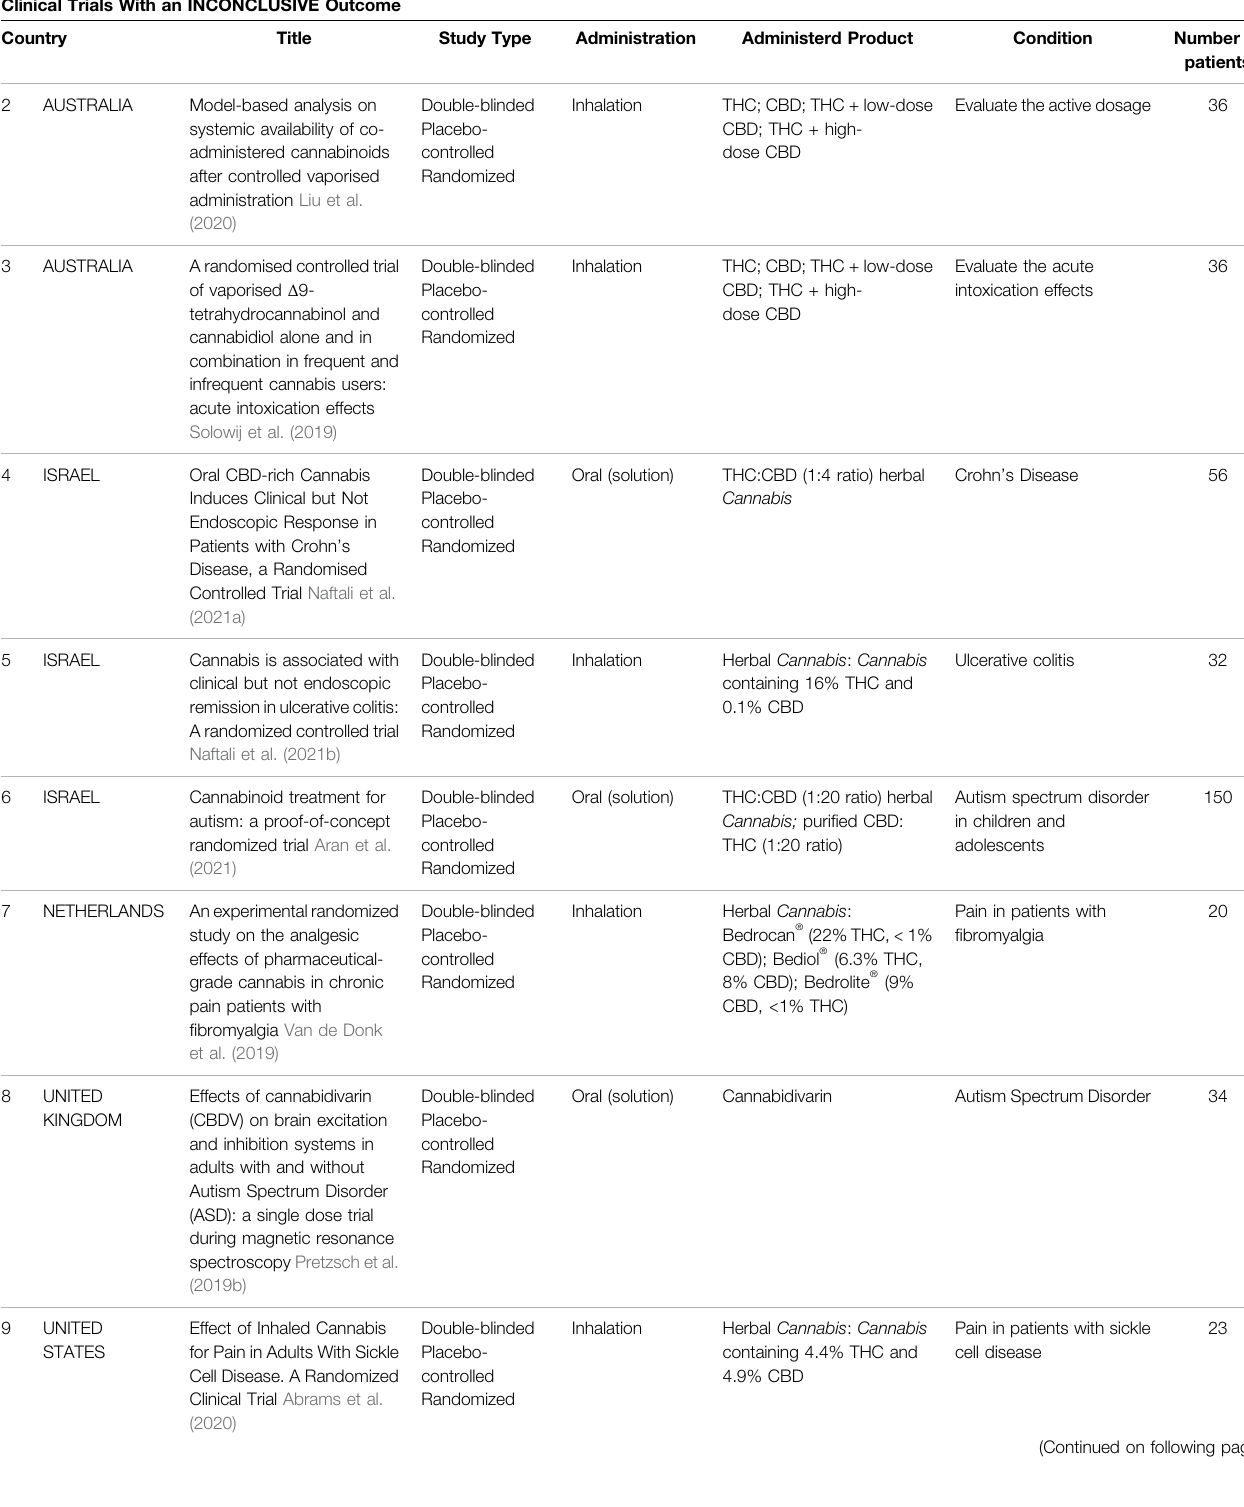
TABLE 1 | ( Continued ) Characteristics of the selected clinical